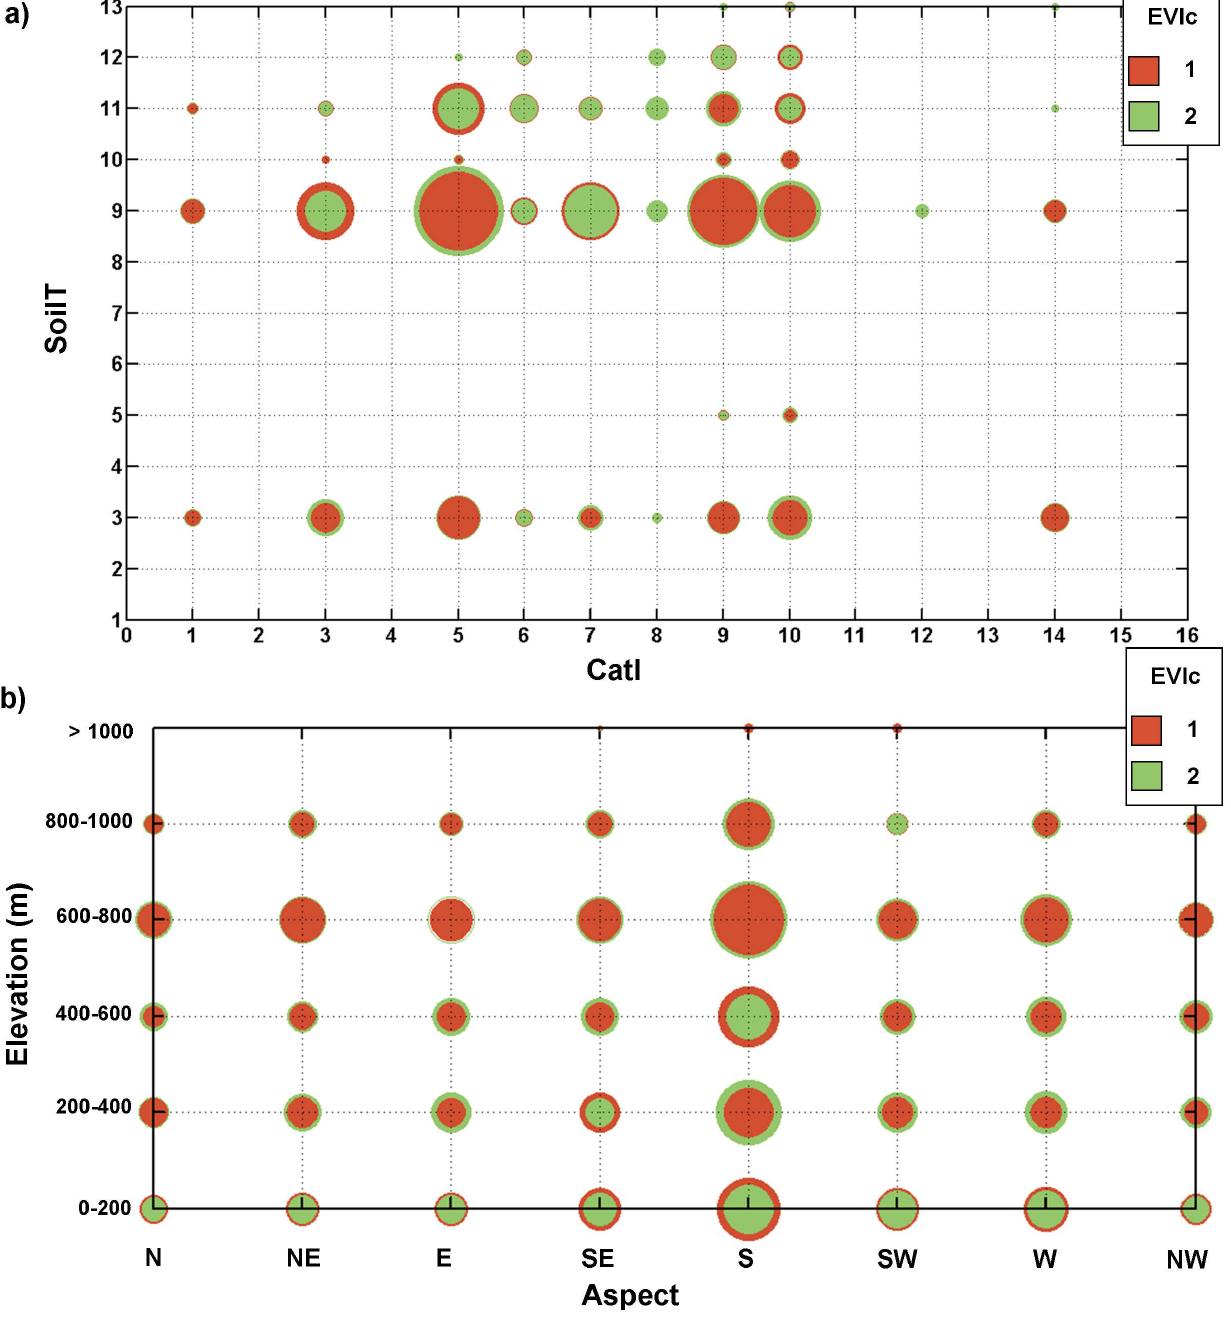
Figure 4. Integrated analysis. a) Circular accumulated EVIc (1 – red, 2 – green) as a function of the SoilT and CatI for all vineyards in Iberia. b) Circular accumulated EVIc as a function of the elevation and aspect for all vineyards in Iberia. The size of each circular chart depicts the accumulated vineyard area belonging to that EVI class, and the inner (outer) circular class depicts the largest (smallest) EVI class.